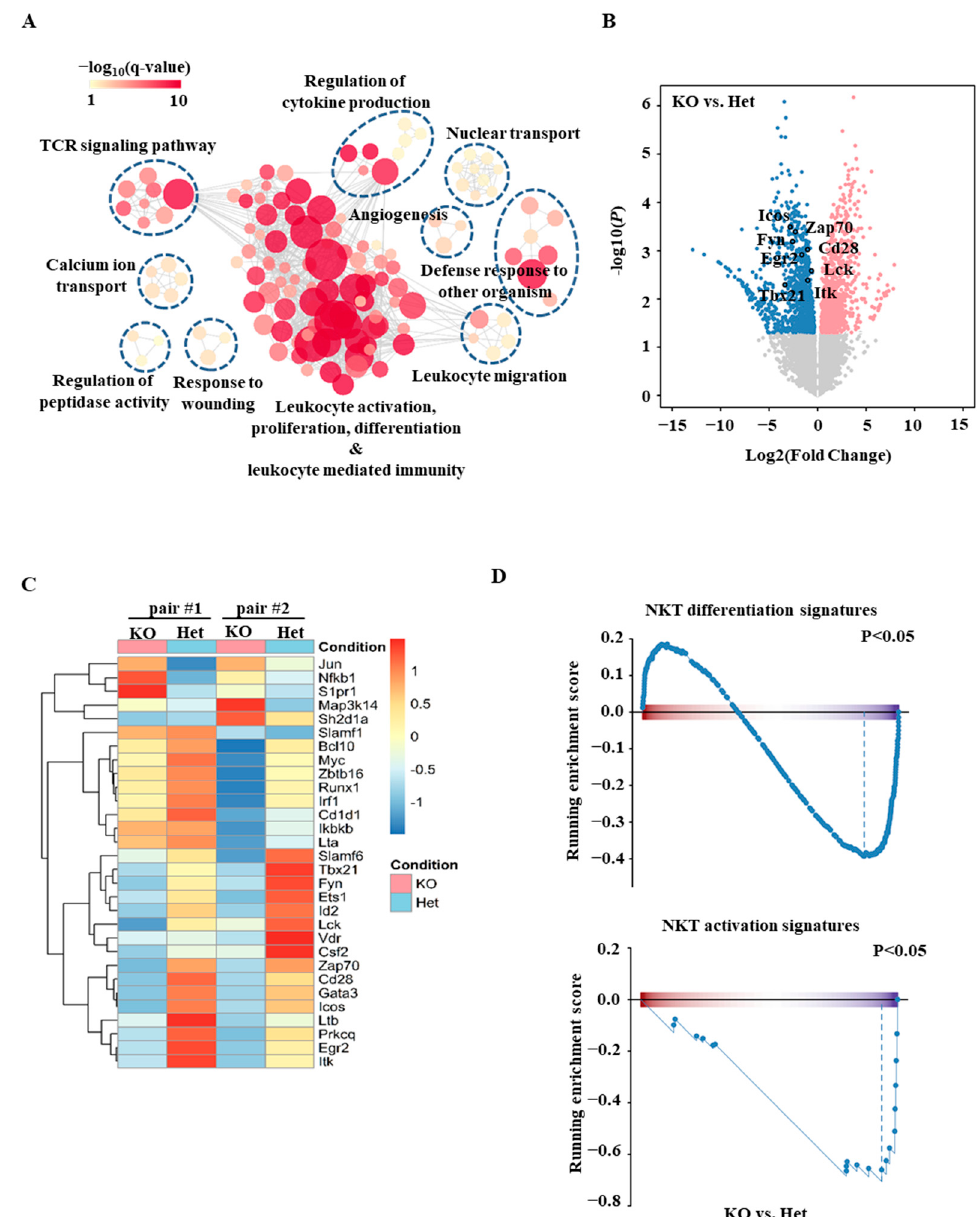
Figure 3. Transcriptomic analyses of Ets1KO iNKT cells. Stage 0 iNKT cells from Het and Ets1KO mice were sorted and subjected to RNA-based next-generation sequencing (RNA-seq). ( A ) The enrichment map shows the significantly suppressed functions in KO compared with Het stage 0 iNKT cells. Nodes are GO gene sets, and edges indicate shared genes between GO gene sets. Node size represents the number of perturbed genes in a given set. ( B , C ) Differences in various genes’ expression in Het and KO stage 0 iNKT cells are shown in a volcano plot ( B ) and a heat map ( C ). p -value < 0.05 was used to identify differentially expressed genes in the volcano plot. The heat map represents data from two independent RNA-seq. ( D ) The results of GSEA analyses of NKT differentiation signatures (upper panel) and NKT activation signature (lower panel) of Het and KO stage 0 iNKT cells are